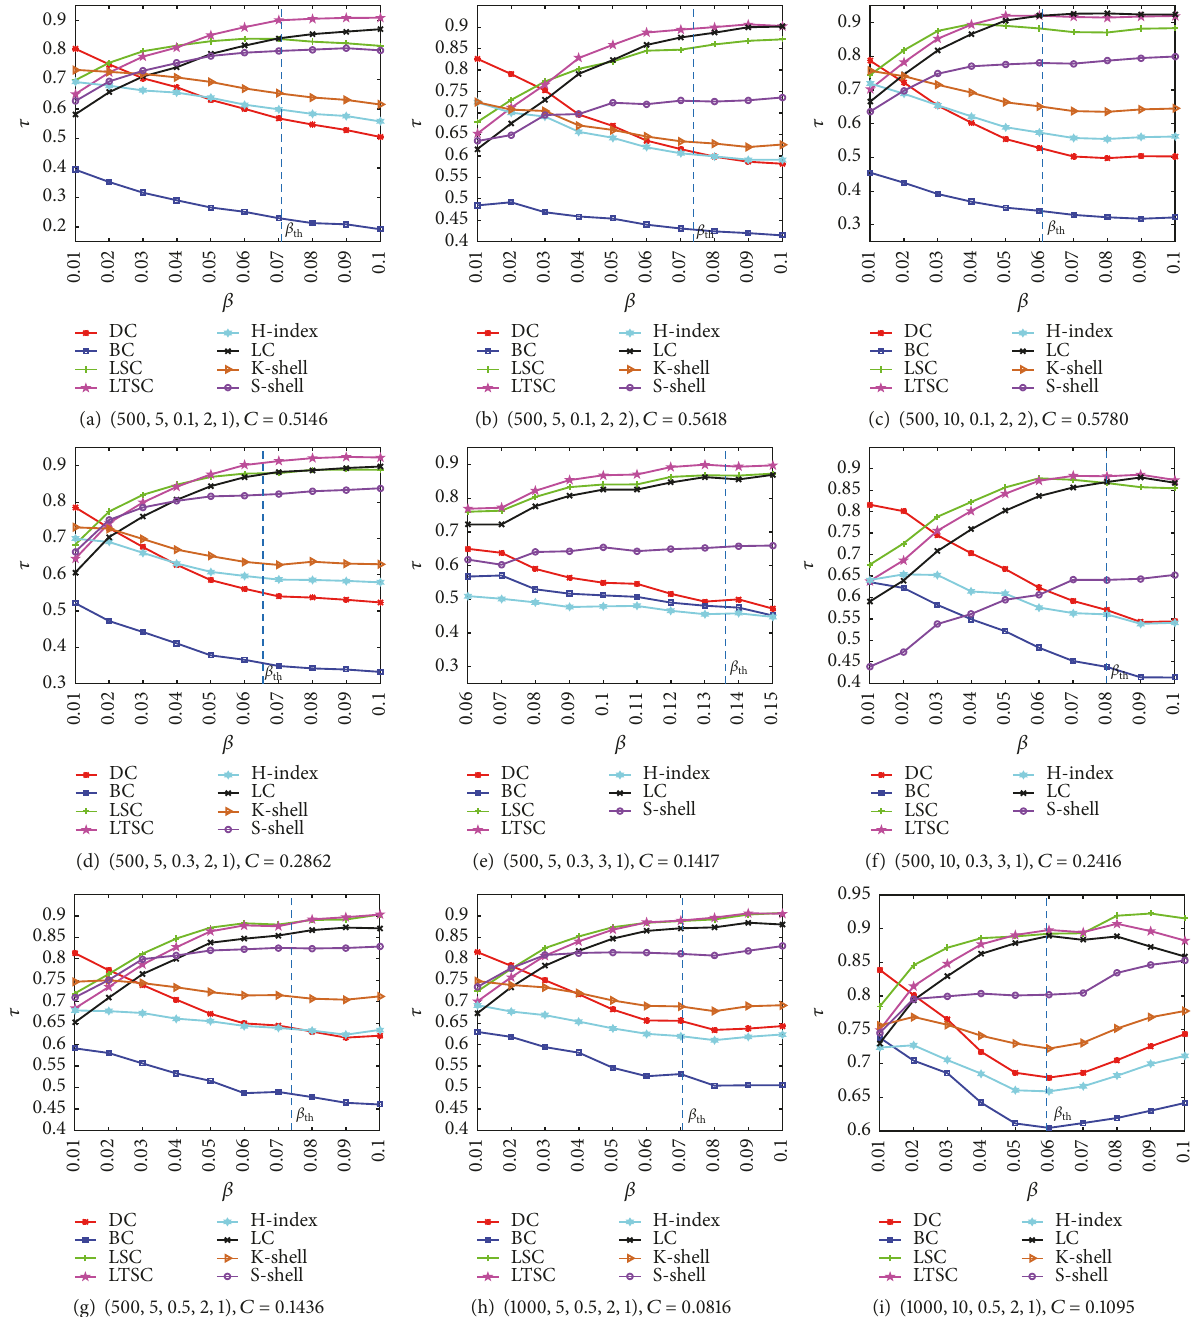
Figure 8: Kendall’s 𝜏 coefficients of the ranks obtained from one of eight measures and the SIR model in the LFR networks, where the parameters (𝑛, ⟨𝑑⟩, 𝜇, 𝛾, 𝜆) are defined as the above text, and 𝐶 is the cluster coefficient. The infection probability 𝛽 is around the threshold 𝜃 𝑡ℎ . The eight measures are DC, BC, H-index, K-shell, S-shell, LC, LSC, and LTSC.